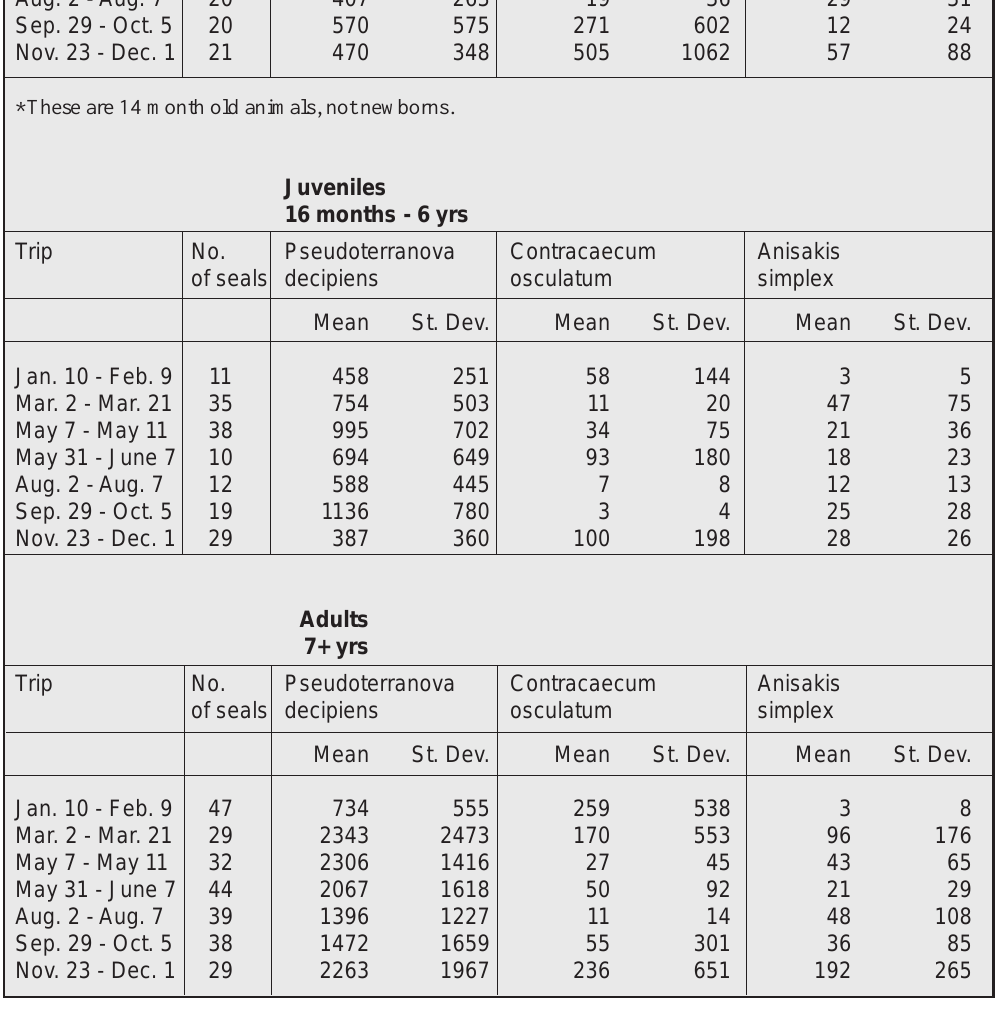
Fig. 1 Quantile plots of the residuals from the final models of worm abundance in grey seals. A per- fect Gaussian fit line for each model is